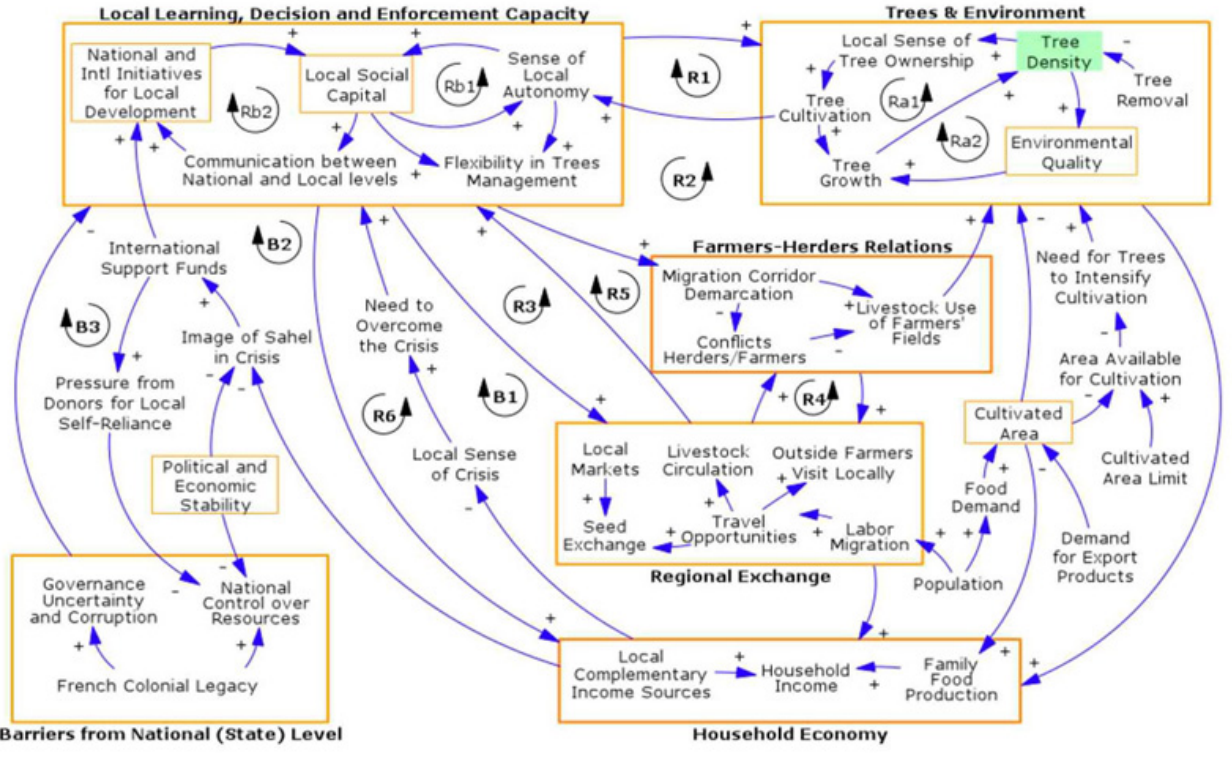
Fig. 10 . General overview of ecological, economic, and social macro relationships influencing the regreening of the Sahel in Maradi Region of Niger. (Complete descriptions of the sequence of variables in each feedback loop are in Appendix